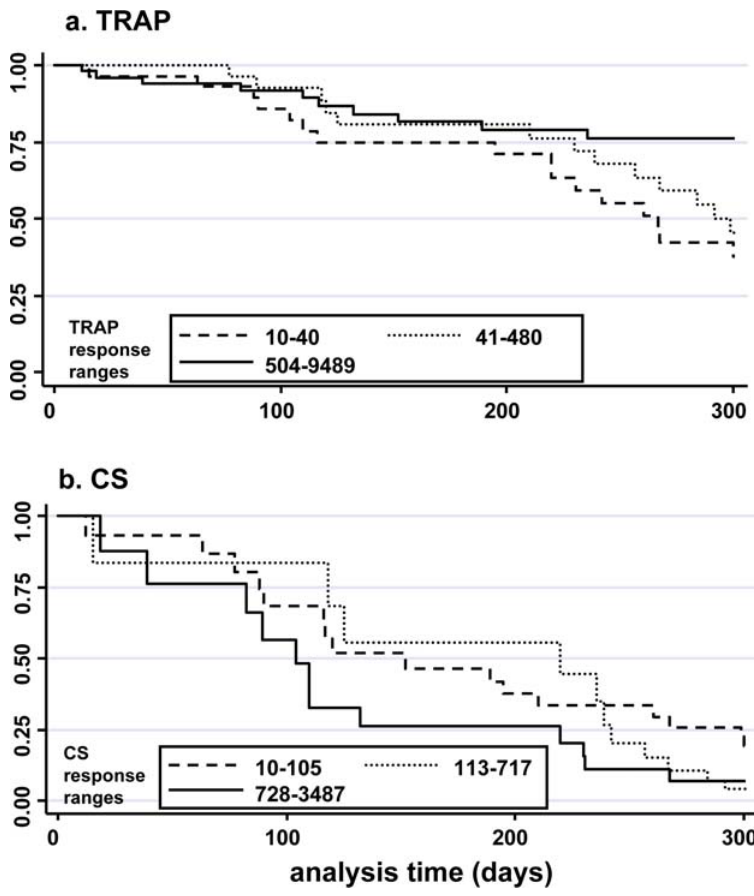
Figure 5. Kaplan-Meier malaria-free survival plots. Individuals were stratified into low, medium and high cultured ELISPOT responders (SFC/ 10 6 ) to (a) TRAP and (b) CS and probability of remaining free of clinical malaria is plotted over the 300 day monitoring period. Co-variants incorporated into the analysis are age and antigen response to the other antigen.